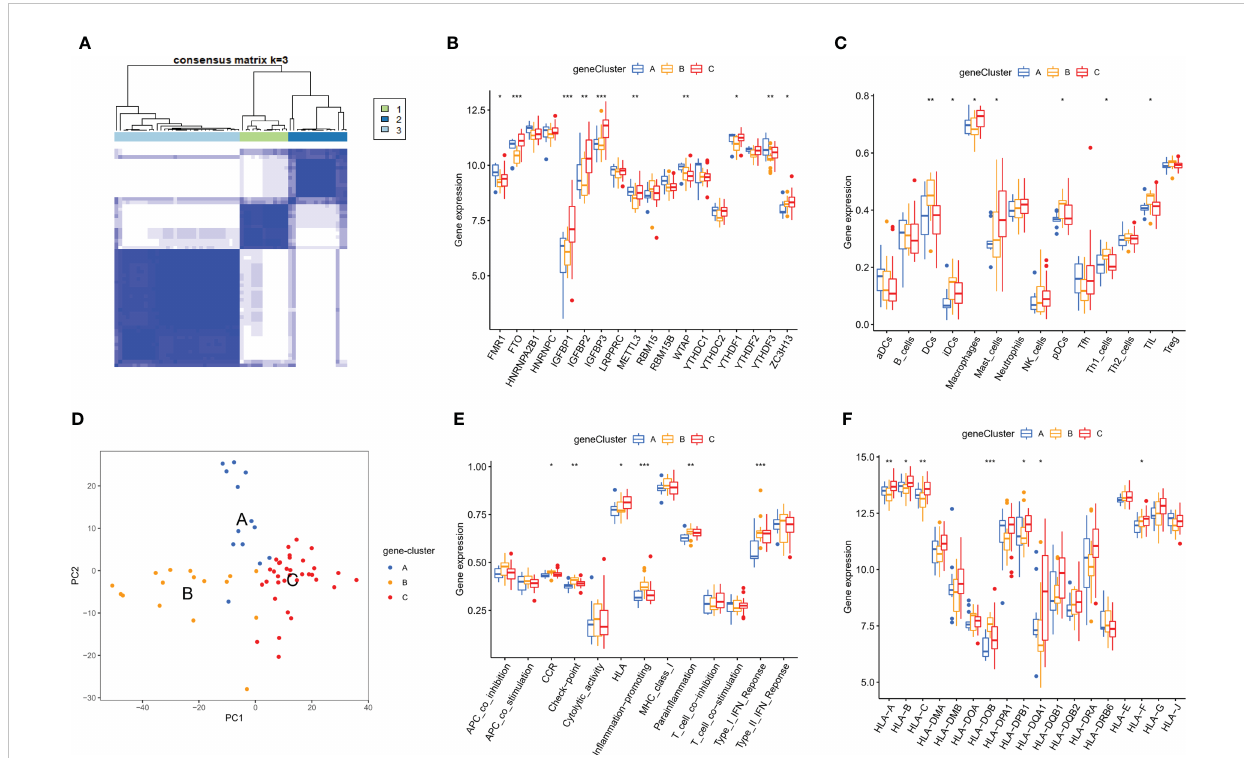
FIGURE 9 Characteristics of the immune microenvironment in m6A phenotype-related genes modi fi cation patterns of OA. (A) Three different m6A phenotype- related genes modi fi cation subtypes of OA by the unsupervised consensus cluster analysis. (B) Principal component analysis of the transcriptome pro fi les indicated the three subtypes were signi fi cantly different. (C-F) Differential expressions of 18 m6A regulators, immunocytes, immune response pathways and HLA genes in the immune microenvironment of m6A phenotype-related genes modi fi cation patterns in OA. *p < 0.05, **p < 0.01, and ***p < 0.001.